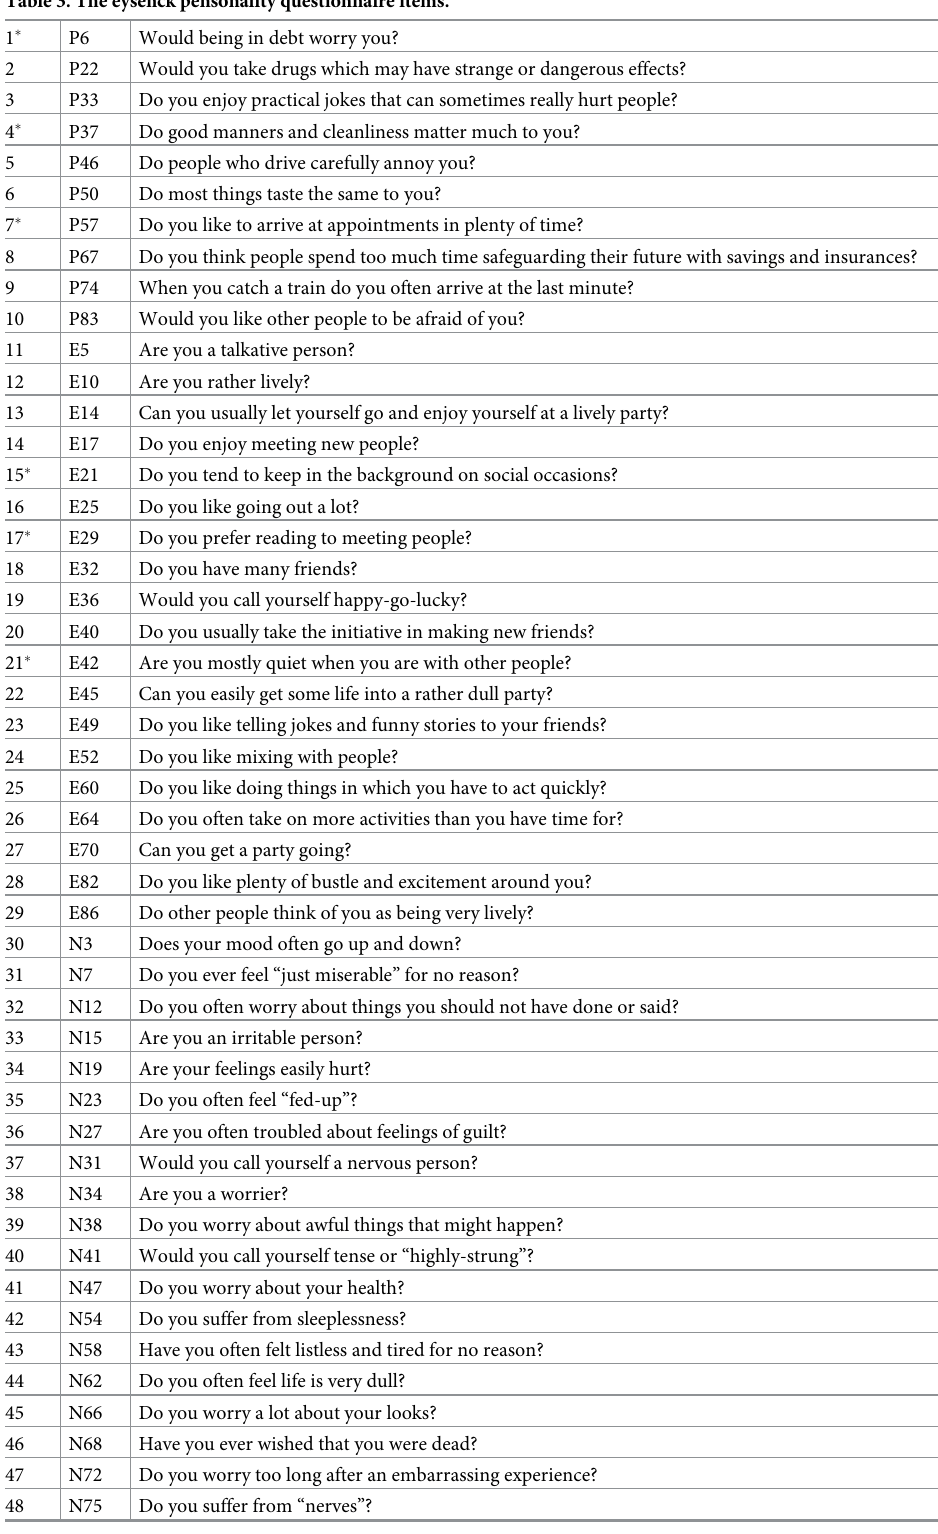
Table 3. The eysenck pensonality questionnaire